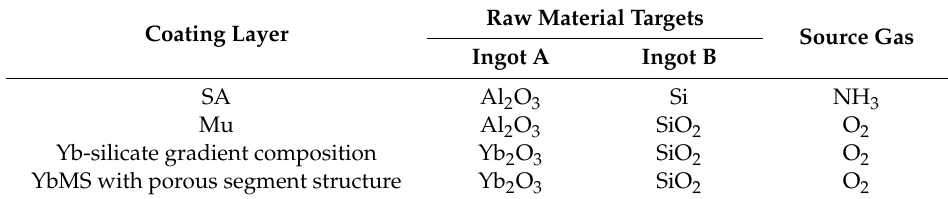
Table 1. Raw material targets and source gases for preparation of T /